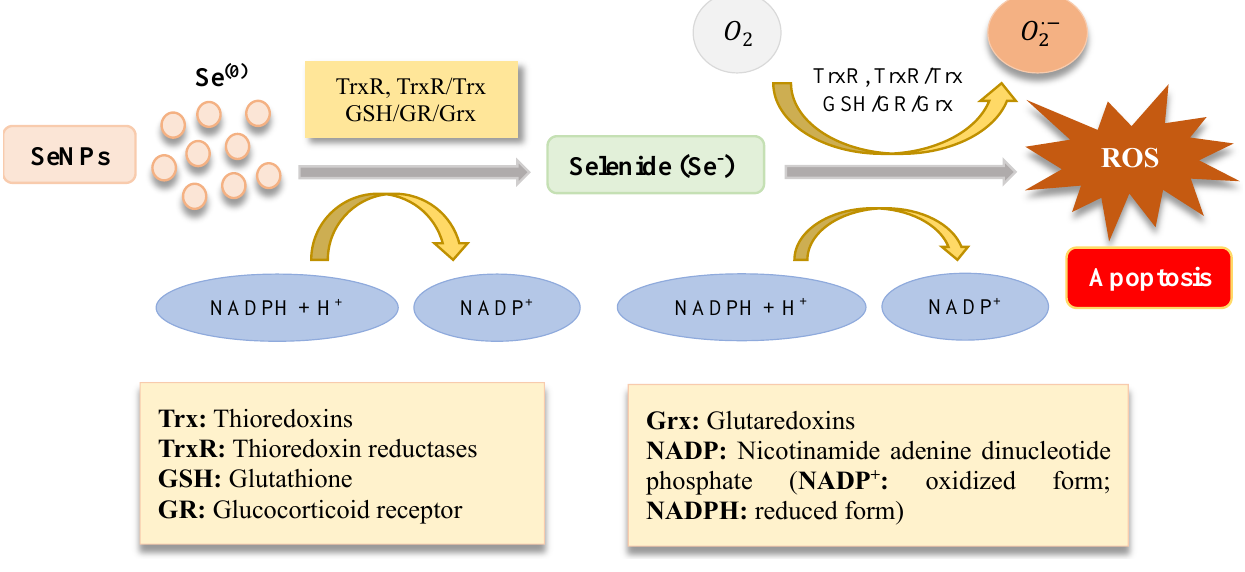
Figure 5. The mechanism of ROS generation mediated by SeNPs. Adapted with permission from Ref. [174]. 2021, The Royal Society of Chemistry.